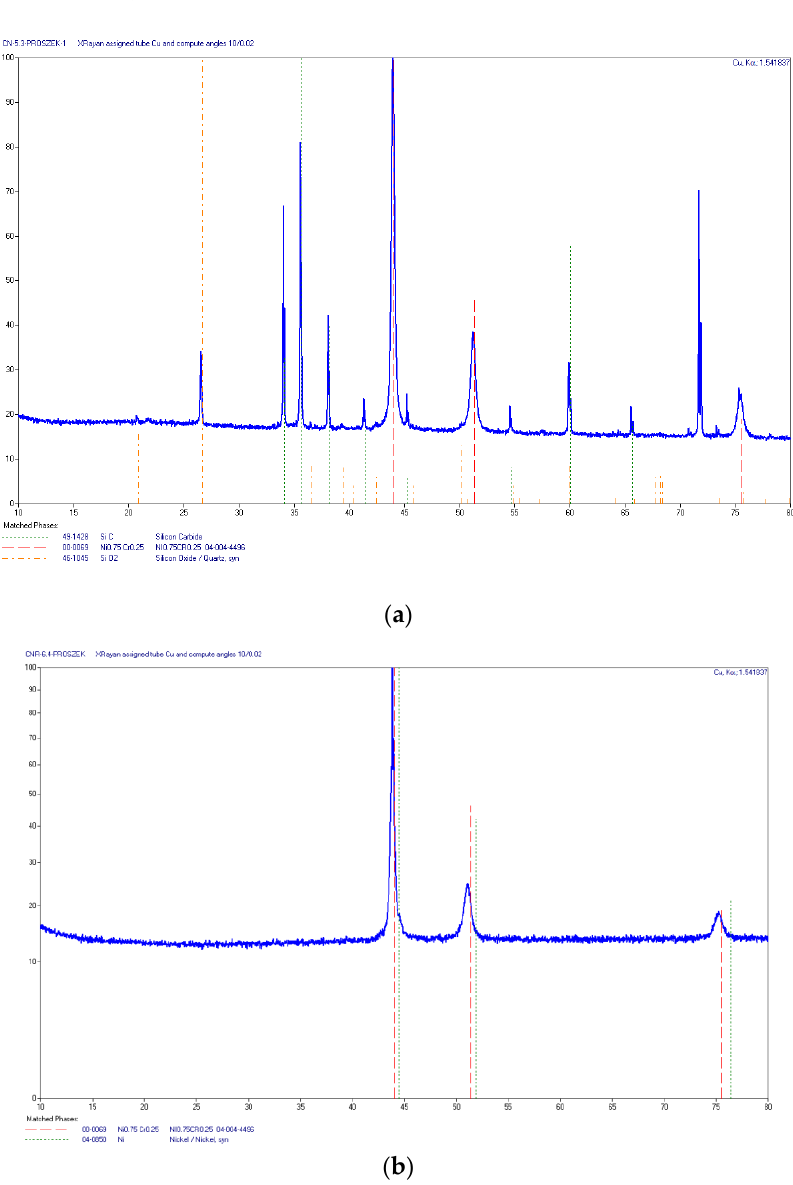
Figure 18. XRD patterns obtained for produced deposits: ( a ) Ni-20Cr, ( b )